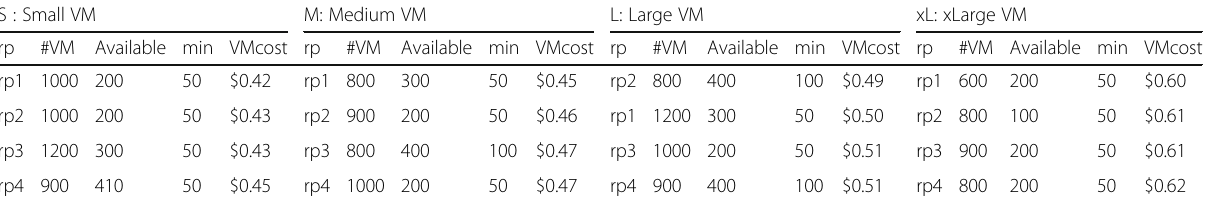
Table 7 Availability and price information of resource providers collected by the CMB (rpSLA) S : Small VM M: Medium